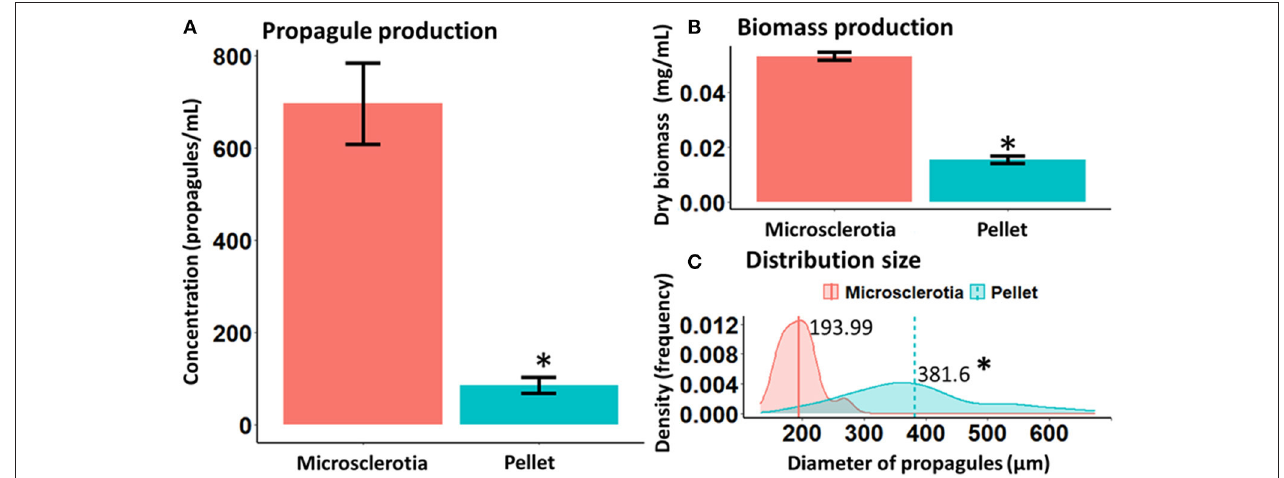
FIGURE 2 | Yield (A) , biomass (B) , and distribution size (C) of microsclerotia and mycelial pellets obtained from 96-h-old liquid cultures of Metarhizium robertsii ARSEF 2575. * p < 0.05.